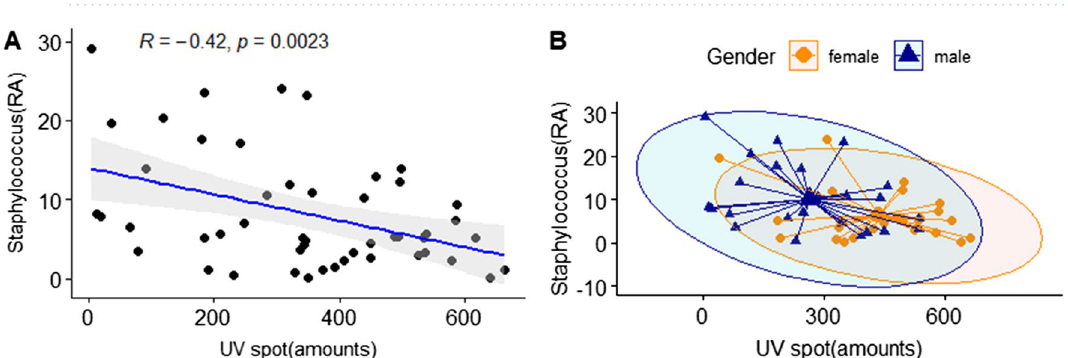
Figure 12. Correlation analysis between the relative abundance (%) of Staphylococcus and clinical skin parameters. ( A ) Pearson correlation between the relative abundance (%) of Staphylococcus and UV spots (amounts); ( B ) gender-related Pearson correlation between the relative abundance (%) of Staphylococcus and UV spots (amounts).